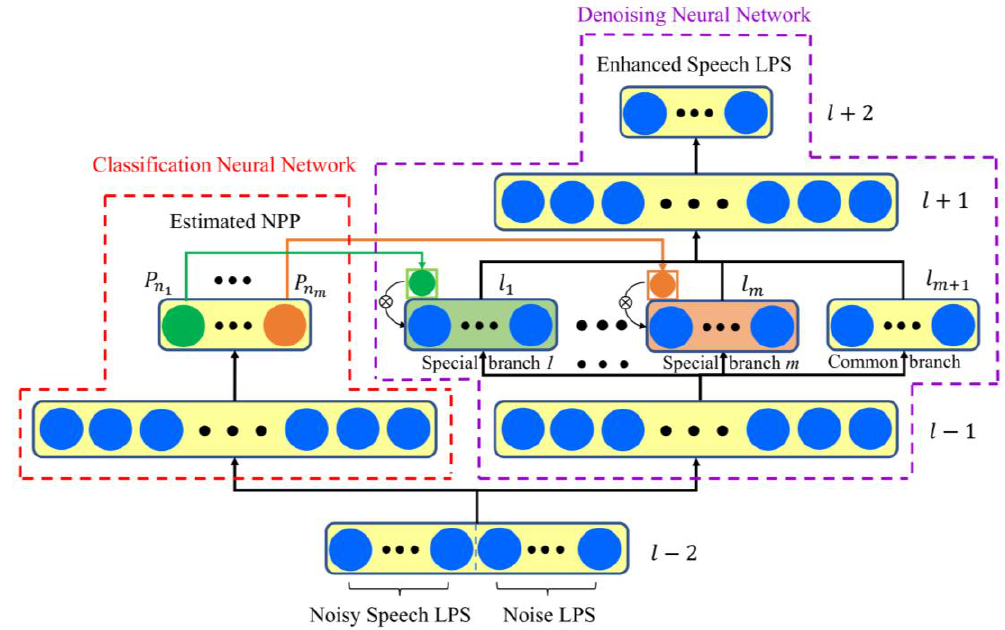
Figure 1. Illustration of the proposed branchy neural network structure that has two key modules, a classification neural network and a denoising neural network.